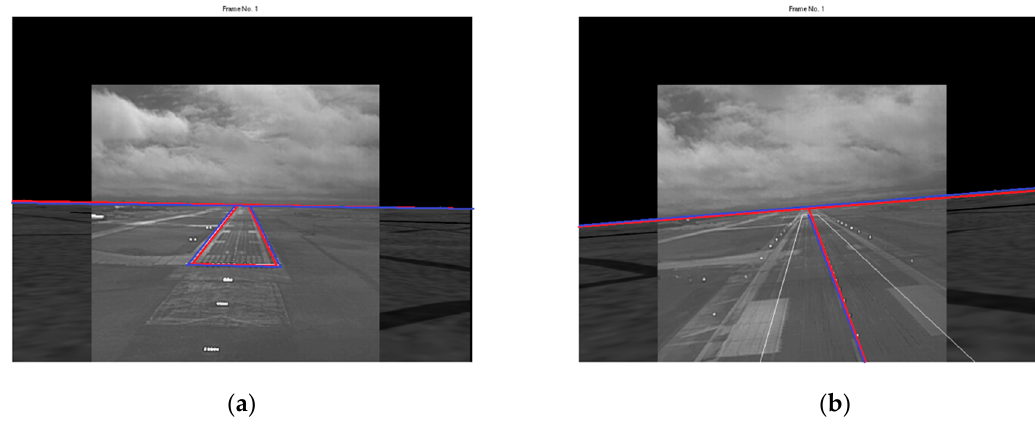
Figure 7. Examples of EVS-SVS image fusion with registration. ( a ) EVS and SVS runways and horizons are aligned; ( b ) EVS and SVS horizons and center lines are aligned.